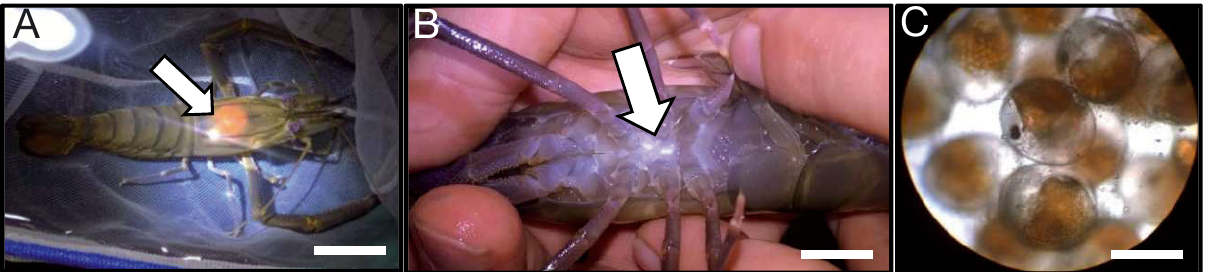
Fig. 3. Outcomes of encounters between Macrobrachium vollenhovenii males and receptive M. vollenhovenii females. (A) Fe- male dorsal view showing a developed ovary (arrow). Bar represents 2 cm. (B) Female ventral view — spermatophores are de- posited on the female’s receptaculum (arrow). Bar represents 1 cm. (C) Examination of fertilized eggs under a microscope. Eyed eggs indicate normal embryonic development. Bar represents 0.2